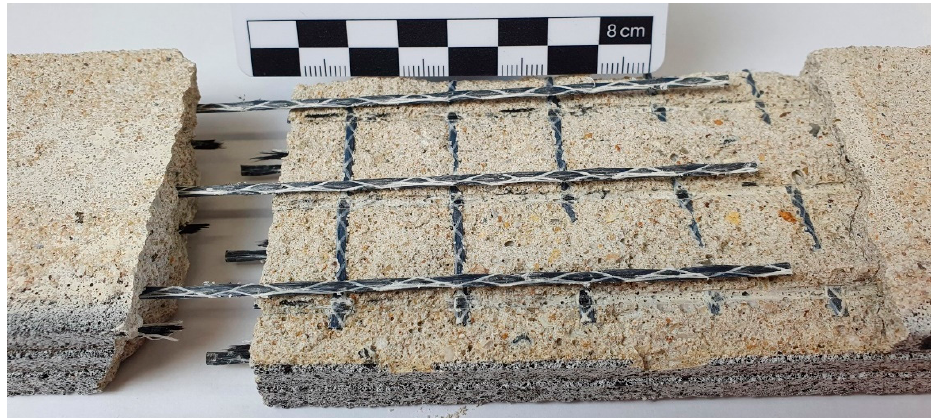
Figure 13. Failure pattern of an overlapping area with a length of 10 cm. Bottom textile layer: yarn rupture; top textile layer: splitting of the mortar cover.